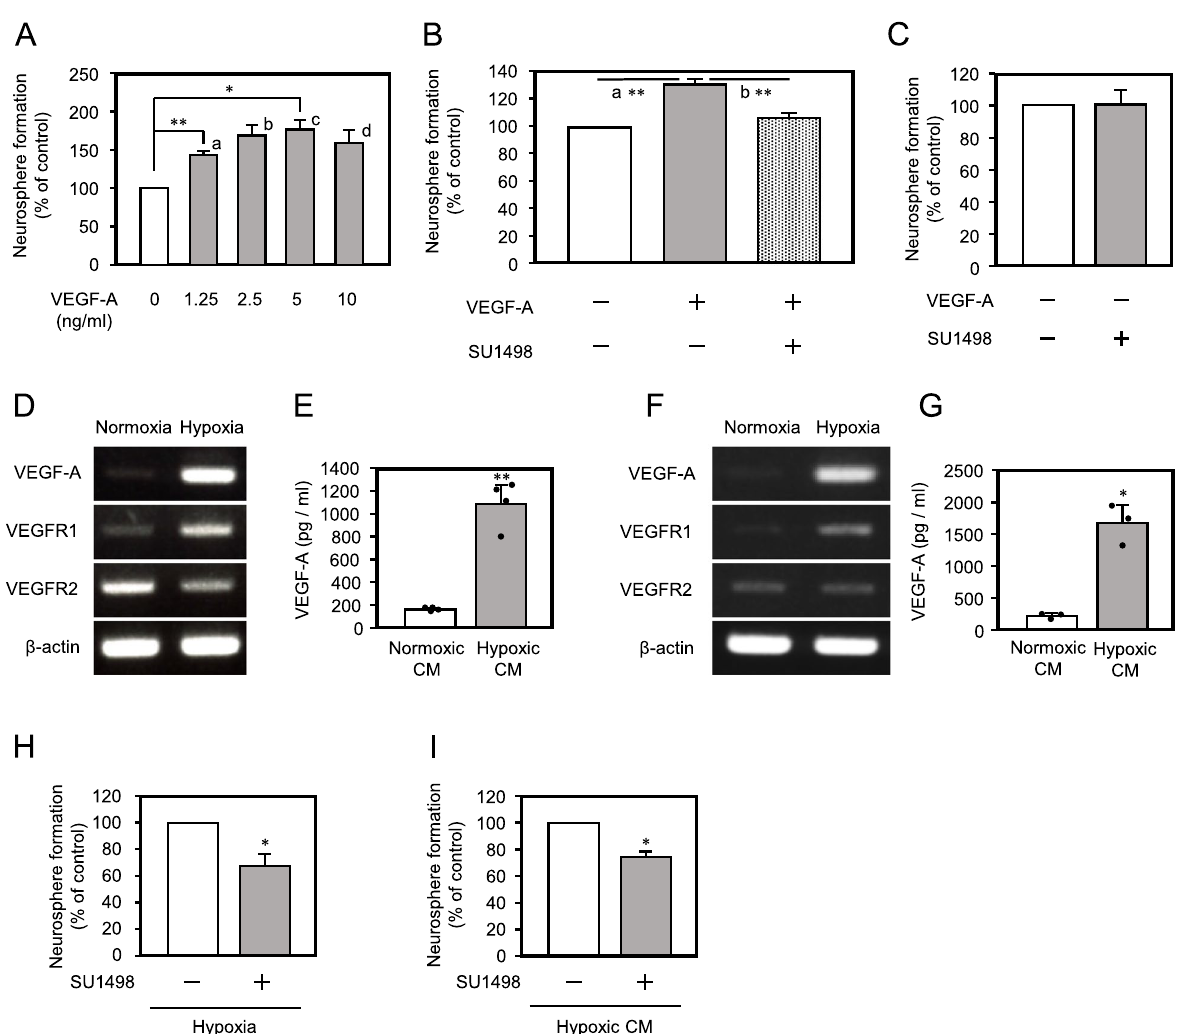
Fig. 3. VEGF-A is secreted from NSPCs and enhances neurosphere formation under hypoxic condition. A Quantification of neurospheres from NSPCs by administration of VEGF-A (mean SEM, n 3, ** p 0.00754, * p 0.0436, ( a p 0.00377, b p 0.0305, c p 0.0218, d p 0.0473 to ± = = = = = = = the control in the case of one-sided test)). B Quantification of neurospheres from NSPCs by administration of 10 ng/ml of VEGF-A and 700 nM of VEGFR2 inhibitor, SU1498 (mean SEM, n 3, a p 0.00555, b p 0.00695). The equivalent volume of DMSO which was used as solvent of SU1498 ± = = = was administrated in the control. C Neurosphere formation from enriched E14.5 NSPCs in the presence of SU1498 (700 nM) under the normoxic condition. D VEGF-A gene expression in NSPCs isolated from E11.5 brain under the hypoxic condition was analyzed by semi-quantitative reverse transcription-PCR. The gel images were cropped and the full-length gel images were shown in Fig. S12A. E Measurement of VEGF-A in the E11.5 NSPC culture under the normoxic or the hypoxic condition by ELISA (mean SEM, n 4, ** p 0.002858). Each black dot indicates the VEGF-A ± = = values in each sample. F VEGF-A gene expression in NSPCs isolated from E14.5 brain under the hypoxic condition was analyzed by semi-quantitative reverse transcription-PCR. The gel images were cropped and the full-length gel images were shown in Fig. S12B, C. The gel image of VEGF-A was inverted horizontally. G Measurement of VEGF-A in the E14.5 NSPC culture under the normoxic or the hypoxic conditions by ELISA (mean SEM, ± n 3, * p 0.01448). H Quantification of neurospheres of NSPCs formed in the hypoxic neurosphere formation culture supplemented with or = = without SU1498 (mean SEM, n 4, * p 0.0482). I Quantification of neurospheres of NSPCs formed in the conventional normoxic neurosphere ± = = formation culture with the hypoxic NSPC CM, supplemented with or without SU1498 (mean SEM, n 4, * p ± = =